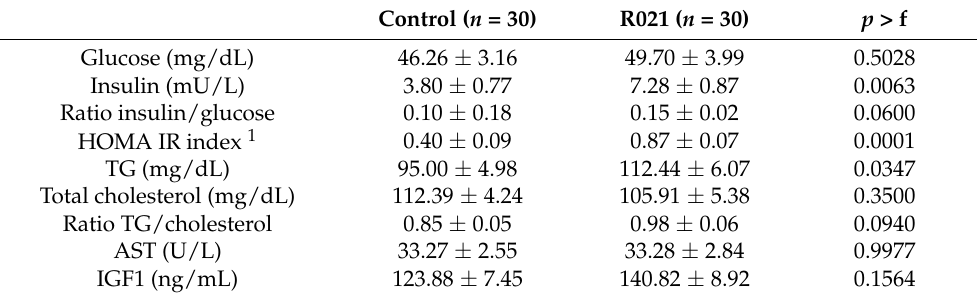
Table 5. Metabolic and hormonal serum parameters and hepatic enzymes levels of fetuses on Day 28 of gestation of ad libitum (Control group) and fed restricted females (105 g/day) during the first two-thirds of gestation and re-fed ad libitum until term (R021 group). Day 0, day of artificial insemination (AI); length gestation, 31 days. Control ( n = 30) R021 ( n = 30) p > f Glucose (mg/dL) 46.26 ± 3.16 49.70 ± 3.99 0.5028 Insulin (mU/L) 3.80 ± 0.77 7.28 ± 0.87 0.0063 Ratio insulin/glucose 0.10 ± 0.18 0.15 ± 0.02 0.0600 HOMA IR index 1 0.40 ± 0.09 Total cholesterol (mg/dL) 112.39 ± 4.24 105.91 ± 5.38 Ratio TG/cholesterol 0.85 ± 0.05 AST (U/L) 33.27 ± 2.55 IGF1 (ng/mL) 123.88 ± 7.45 140.82 ± 8.92